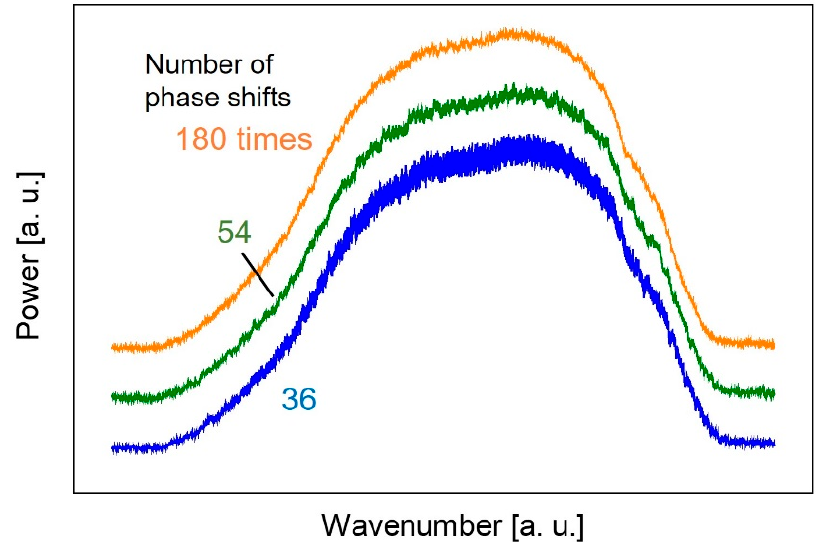
Figure 6. The power spectra measured at three different phase shift numbers.